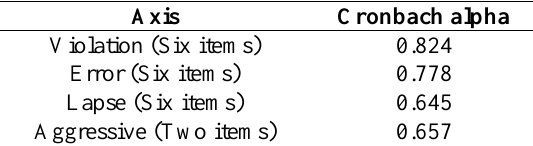
Table 5. Alpha reliability coefficients of the DBQ scales for the short version